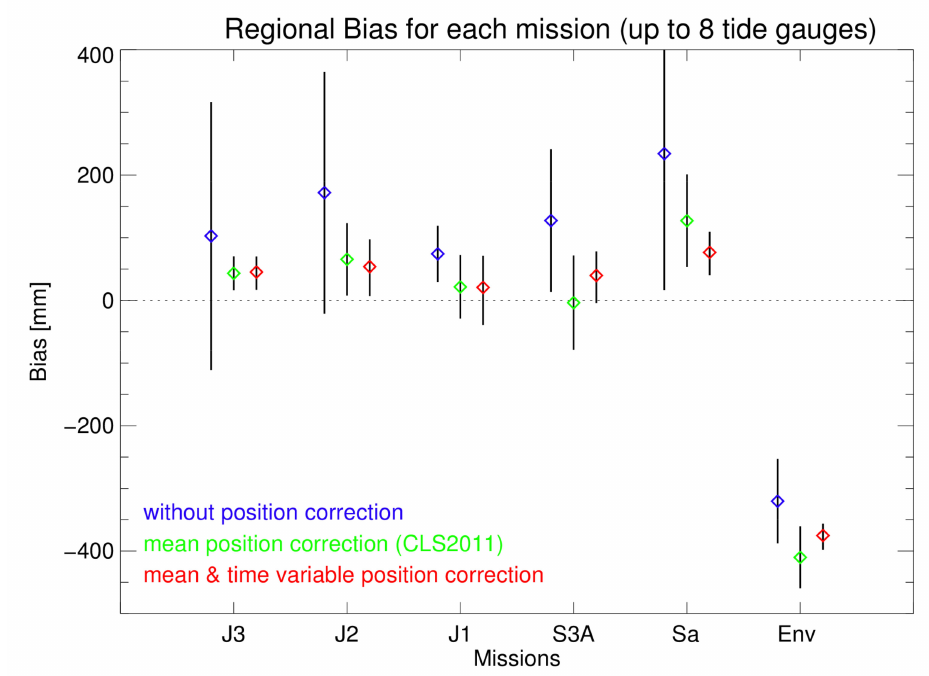
Figure 8. Regional mission biases and error margins for all missions derived from all collocated station pairs, without (blue), with mean (green), with mean and time variable (red) position correction for Jason-3 (J3), Jason-2 (J2), Jason-1 (J1), Sentinel-3A (S3A), Saral (Sa) and Envisat